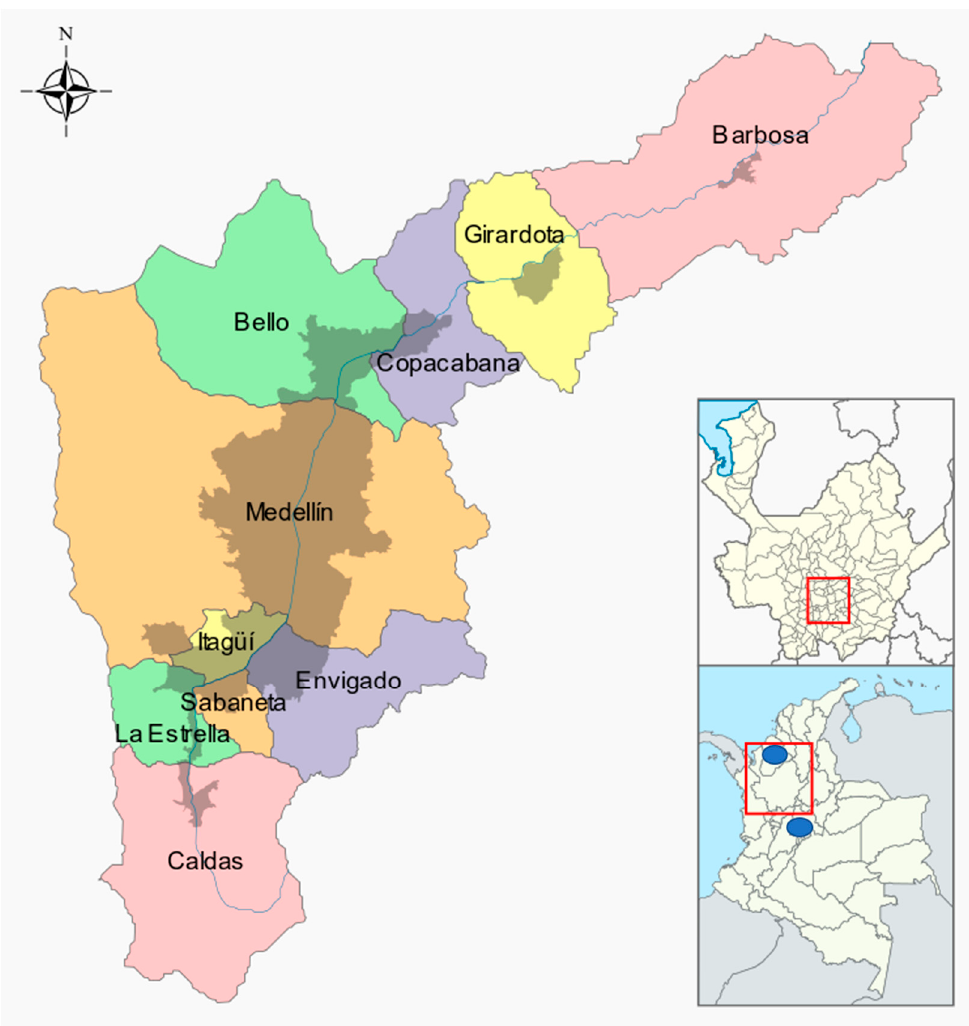
Figure 1. Geographical location of the Aburrá Valley, where the antigenic and molecular presence of FeLV was assessed. Magnification area defined in red box. The grey shadow represents urban areas. The blue dots in lower right panel represent the cities of Monteria and Bogotá. The map was obtained from the official page of the metropolitan area of the Aburrá Valley (CC BY-SA 4.0 license). See text for references.